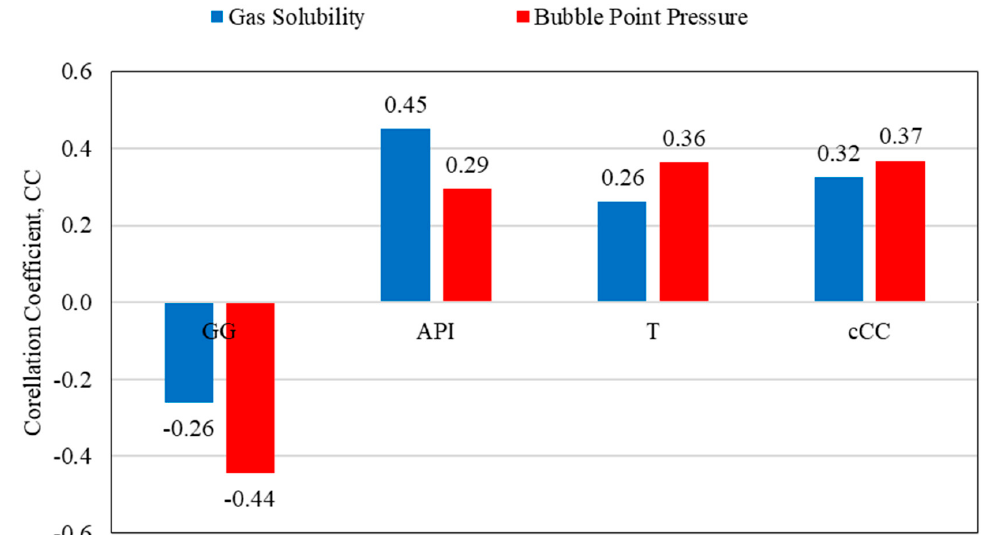
Figure 1. Correlation coefficients of reservoir temperature ( T ), oil API, and gas gravity (GG) to bubble point pressure ( Pb ) and gas solubility ( Rs ).